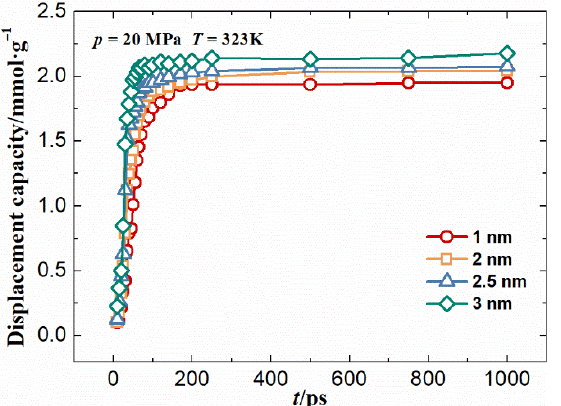
Figure 11. Displacement capacity of CH 4 by CO 2 with different pore sizes.